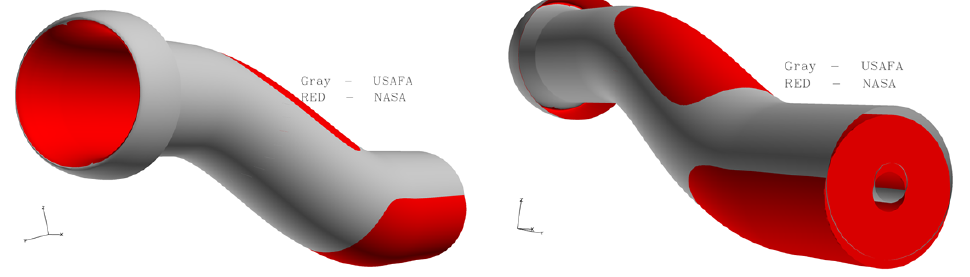
Figure 3. RAE M2129 geometries. NASA model was obtained from Bernhard Anderson. USAFA model was created from given intake data and offset and diameter changes equation with